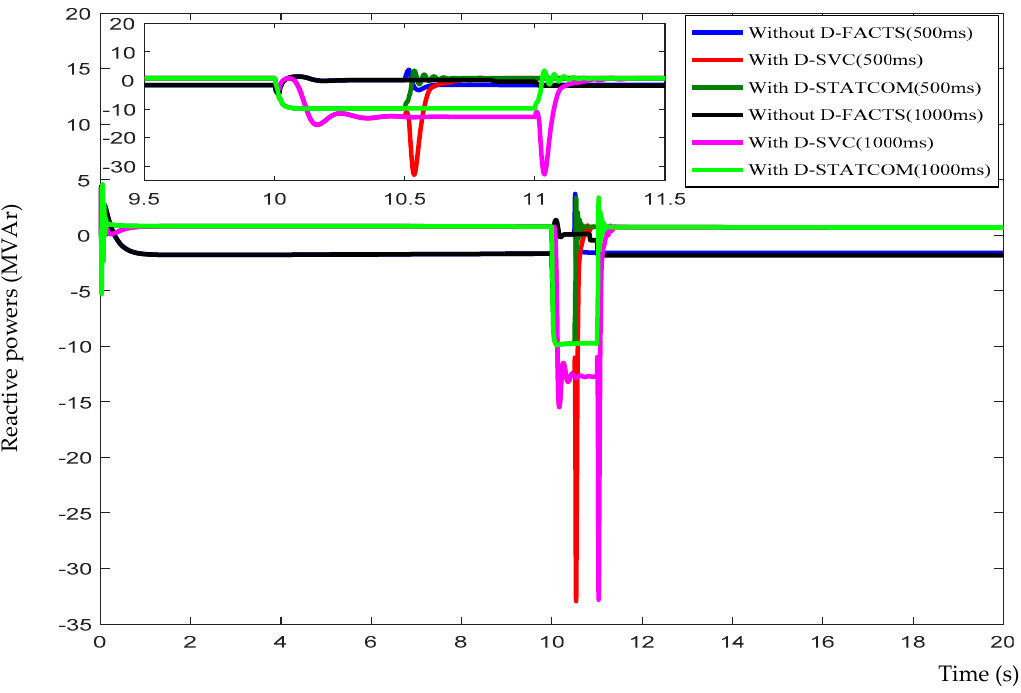
Figure 18. Reactive power at the PCC during the voltage drop at the 60 kV bus.